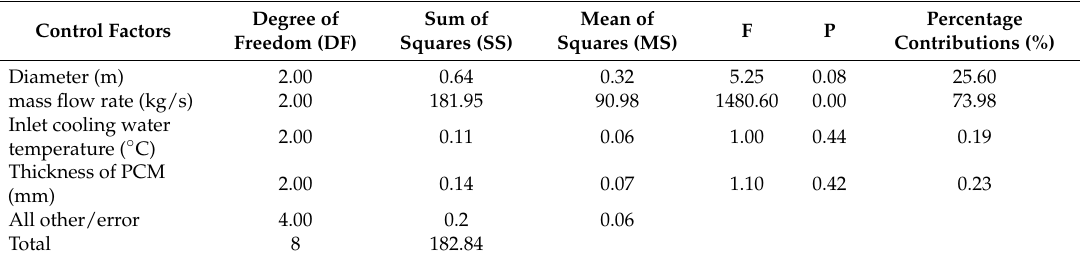
Table 13. Taguchi method − ANOVA analysis of equivalent overall output